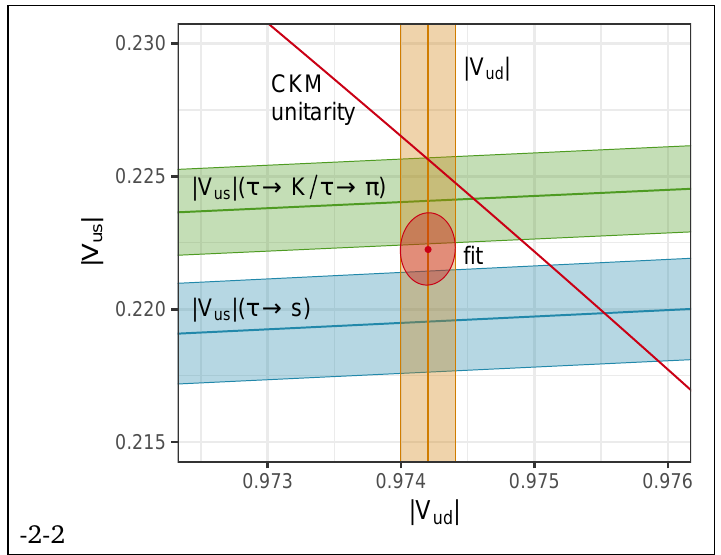
| - | V | simultaneous fit. The bands describe the constraints ud us | measurement, the | V ud